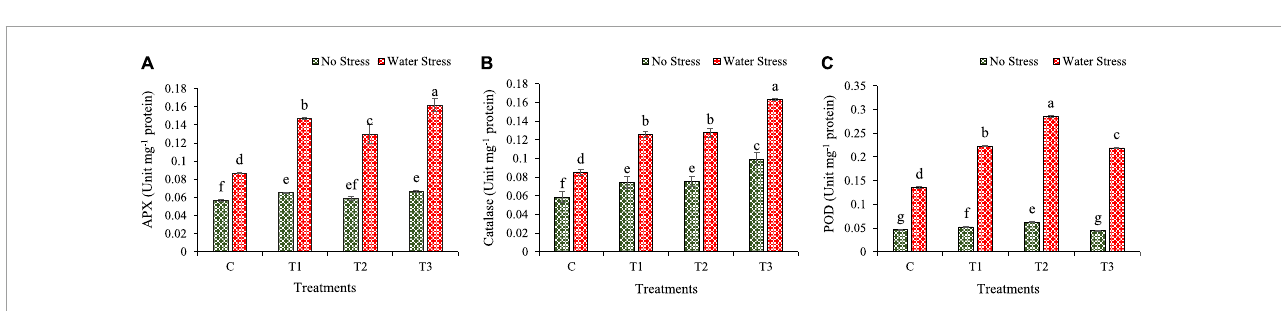
FIGURE8 Impacts of bacterial treatments (T1 — Enterobacter cloacae BHUAS1, T2 — Bacillus megaterium BHUIESDAS3, and T3 — Bacillus cereus BHUAS2) on activities of various antioxidant enzymes of wheat plants under the influence of water-induced drought stress (A) ascorbate peroxidase (APX), (B) catalase (CAT), and (C) peroxidase (POD). The different alphabets indicate statistically significant differences between each treatment (DMRT p < 0.05).